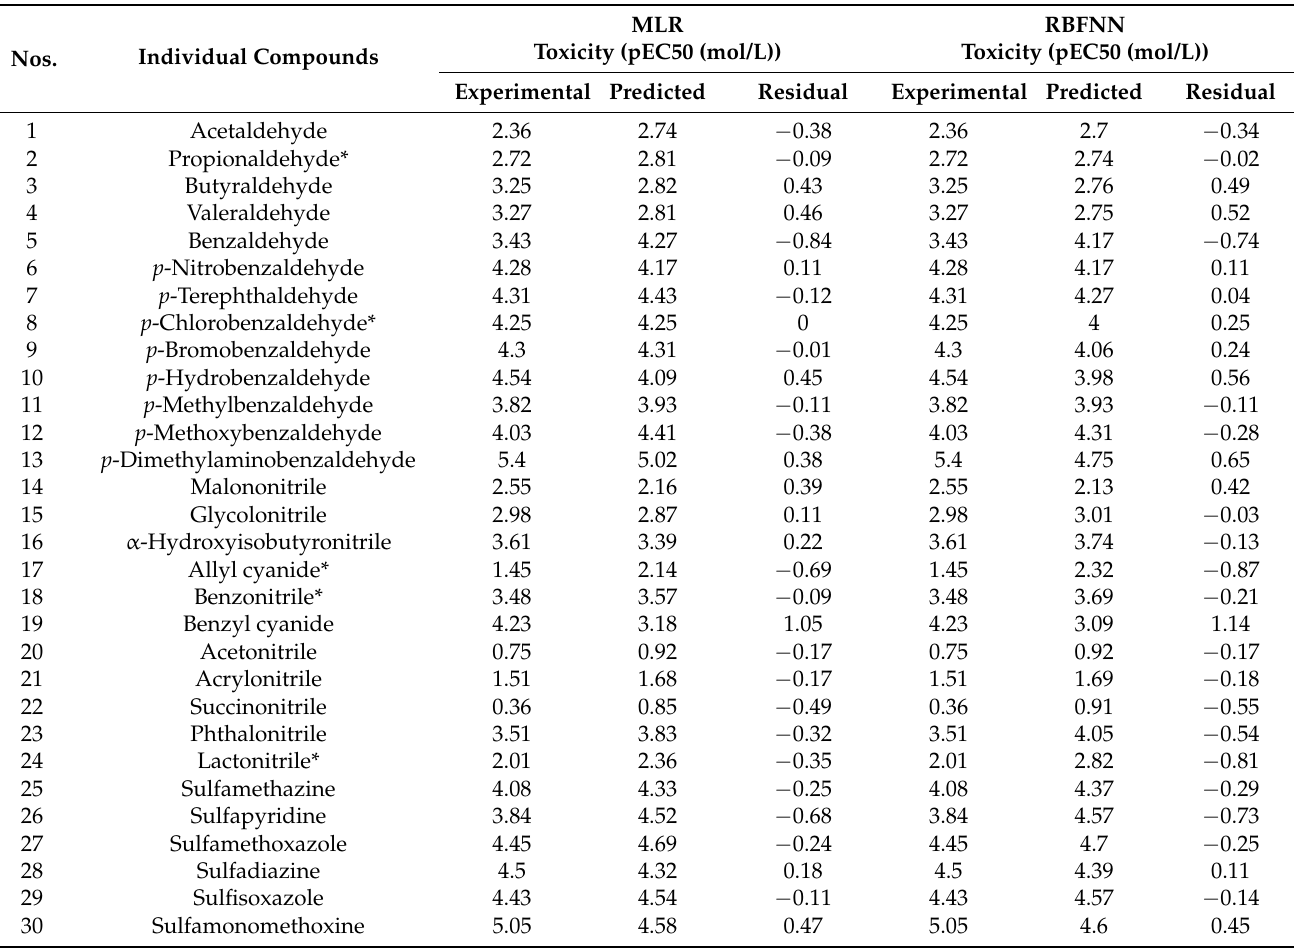
Table 2. Toxicity data of the individual